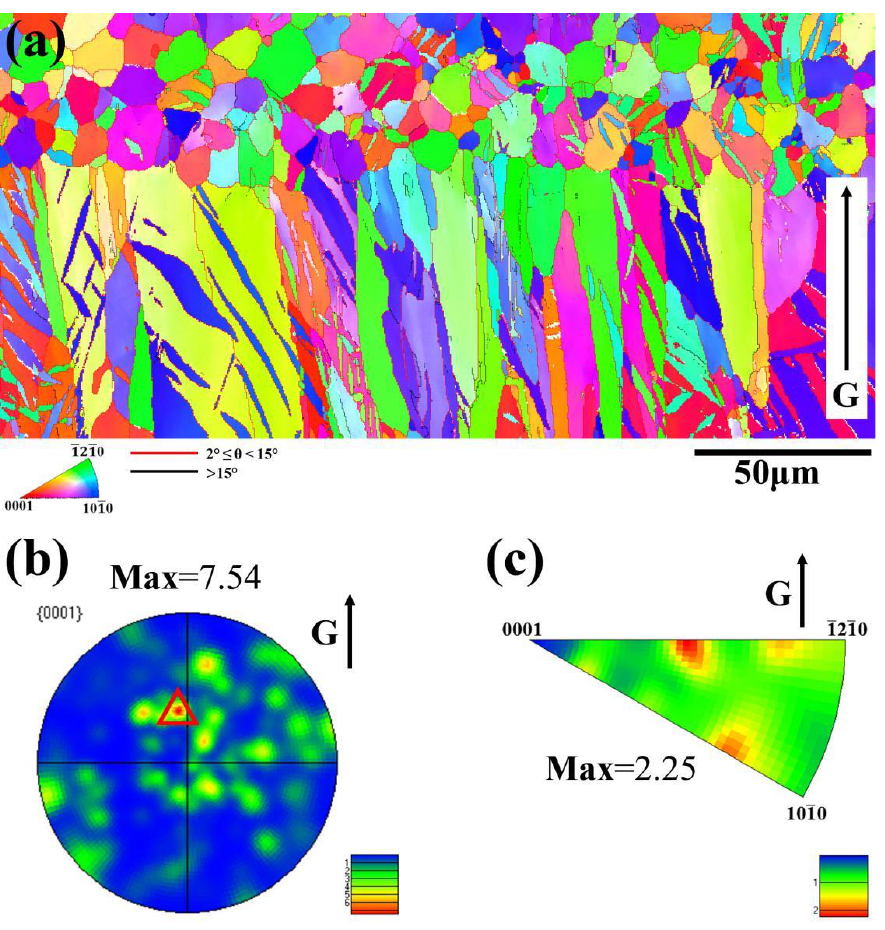
Figure 2. EBSD results of longitudinal section of as-RS AZ31: ( a ) IPF map; ( b ) {0001} PF; ( c ) IPF along thermal gradient.